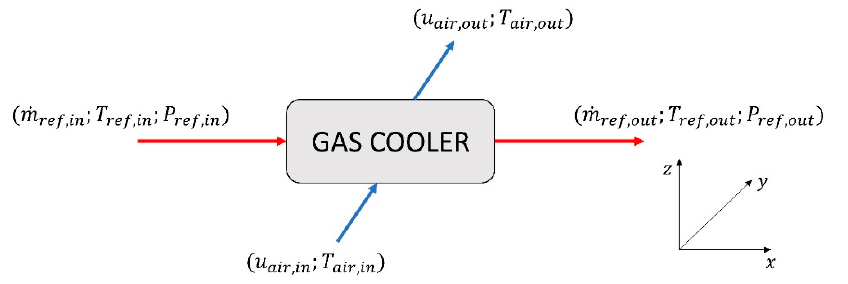
Figure 3. Macroscopic scheme of the gas cooler. Red arrows represent the refrigerant flow, whereas the blue arrows represent the air flow.